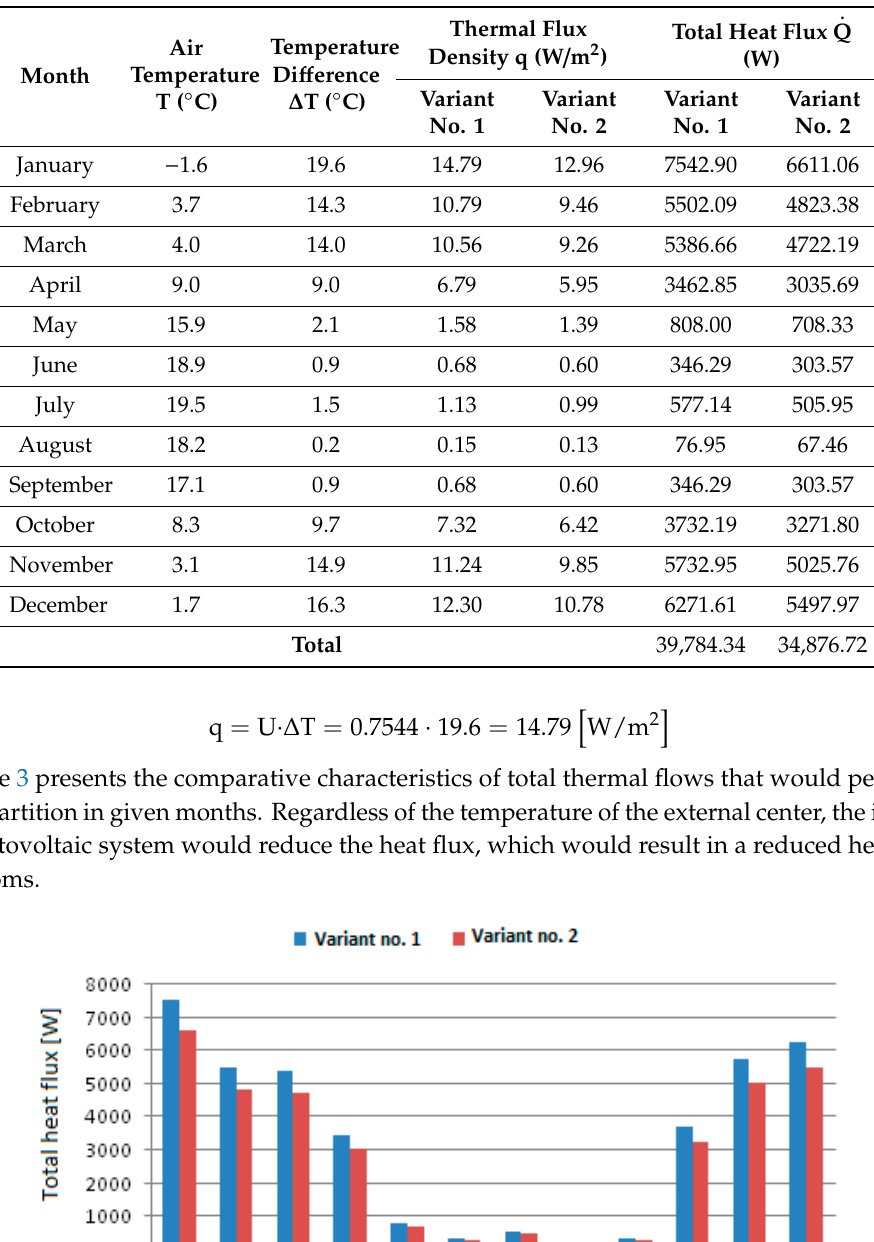
Table 5. Comparison of temperatures and thermal fluxes penetrating the partition [73].